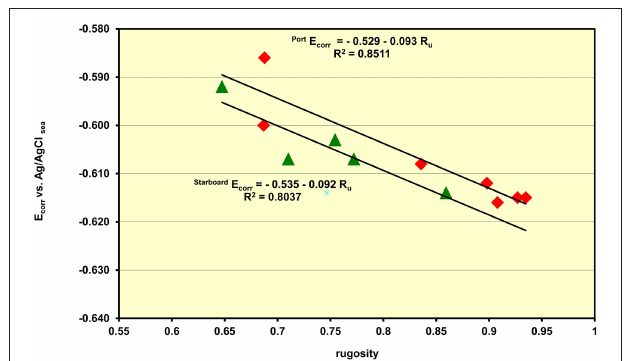
FIGURE 4 | Plot of the rate at which the E corr values move to more protective values as the roughness of the marine growth decreases with increasing depth.